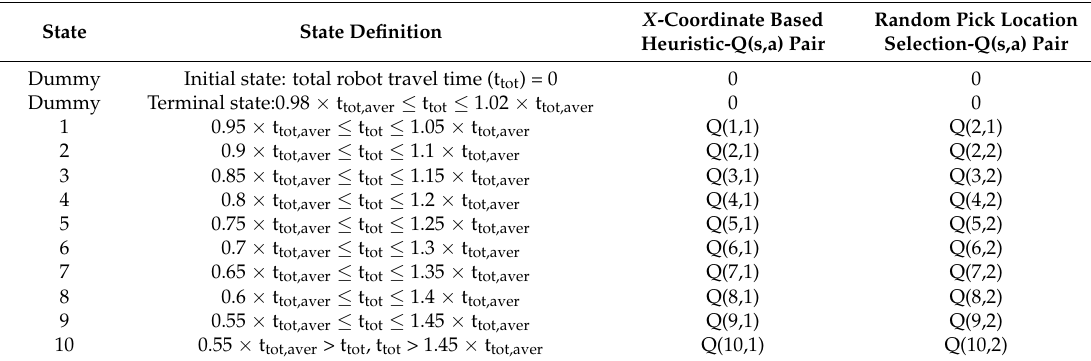
Table 1. Policy table for the scheduling agent.